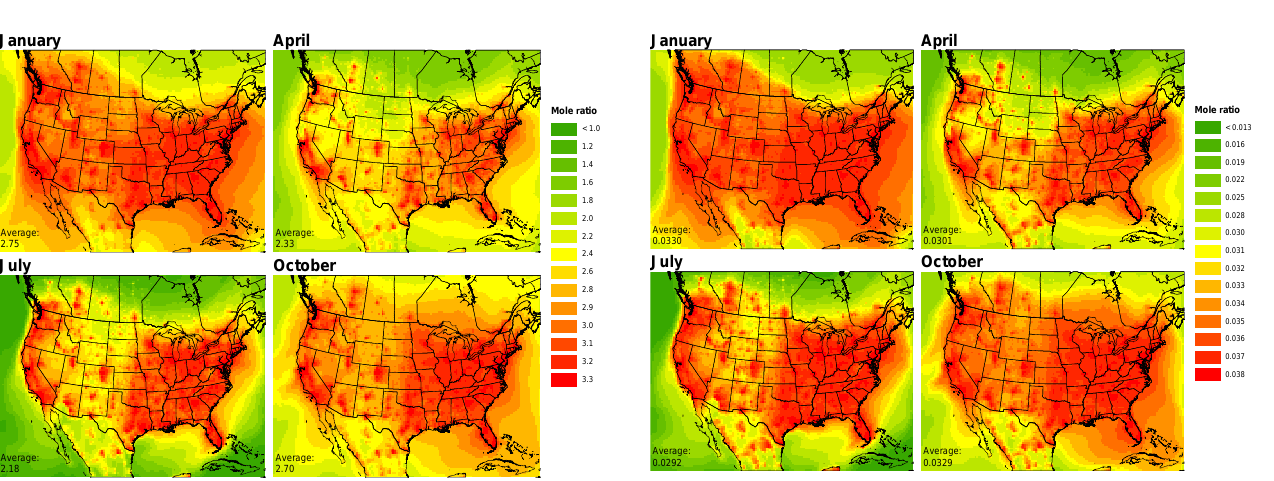
Figure 6. Modeled monthly averaged D 5 / D 4 mole ratios by sea- son. Larger cVMS species react faster with OH. More reactive species are in the numerator; therefore, ratios decrease with air mass age.